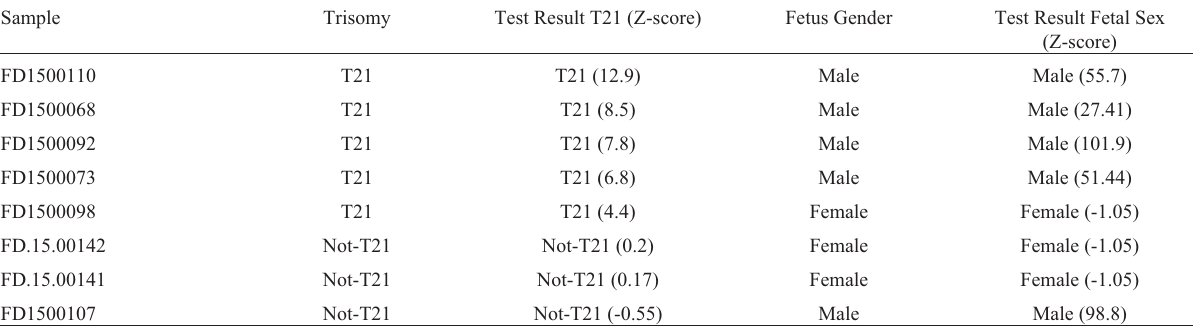
Table 2 - Test results for blind